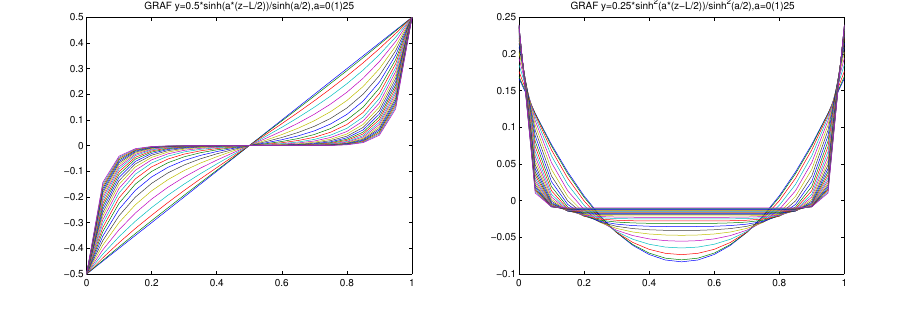
Figure 3. Values of functions f 1 z for hyperbolic spline with a 1 = a 2 ∈ [0 , 25]